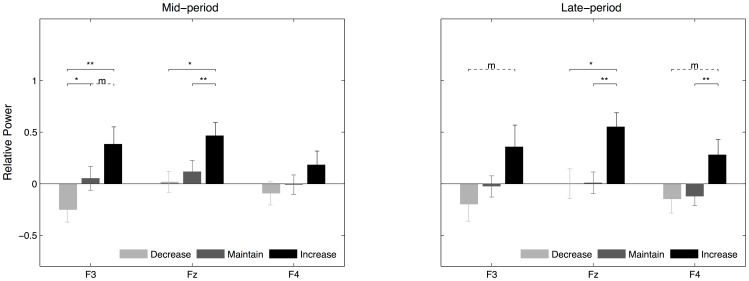
Statistical results in the mid and late interval.Comparison of frontal gamma power across three cognitive reappraisal goals (decrease, light black; maintain, dark gray; increase, black) in the mid (left) and late (right) interval. The error bars indicate standard error of the mean (SEM).